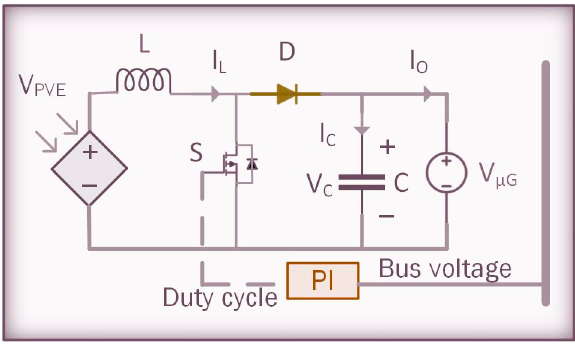
Figure 9. Voltage control (VC) for the boost converter.